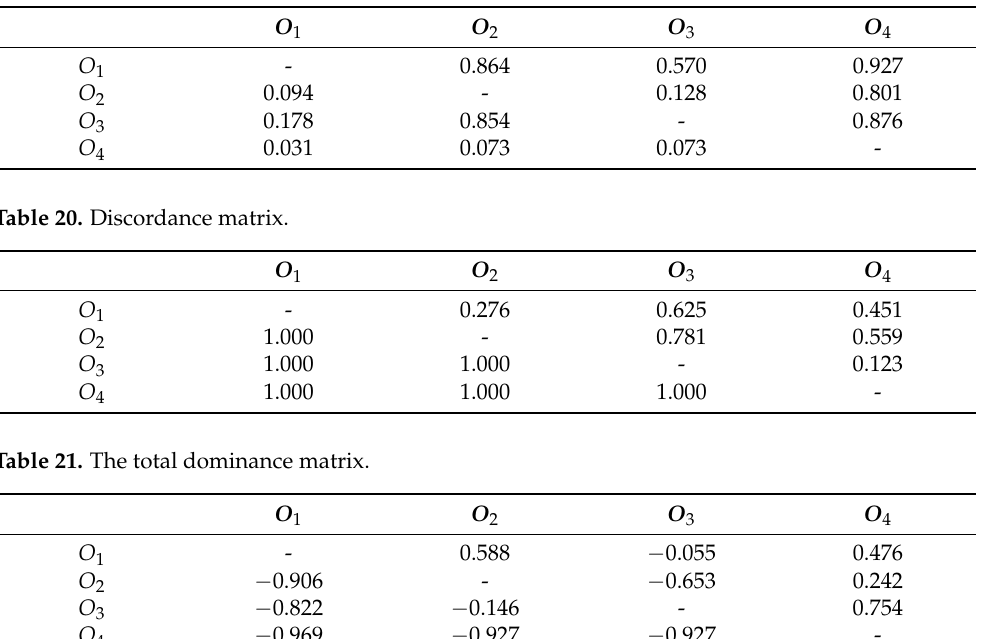
Table 19. Concordance matrix.